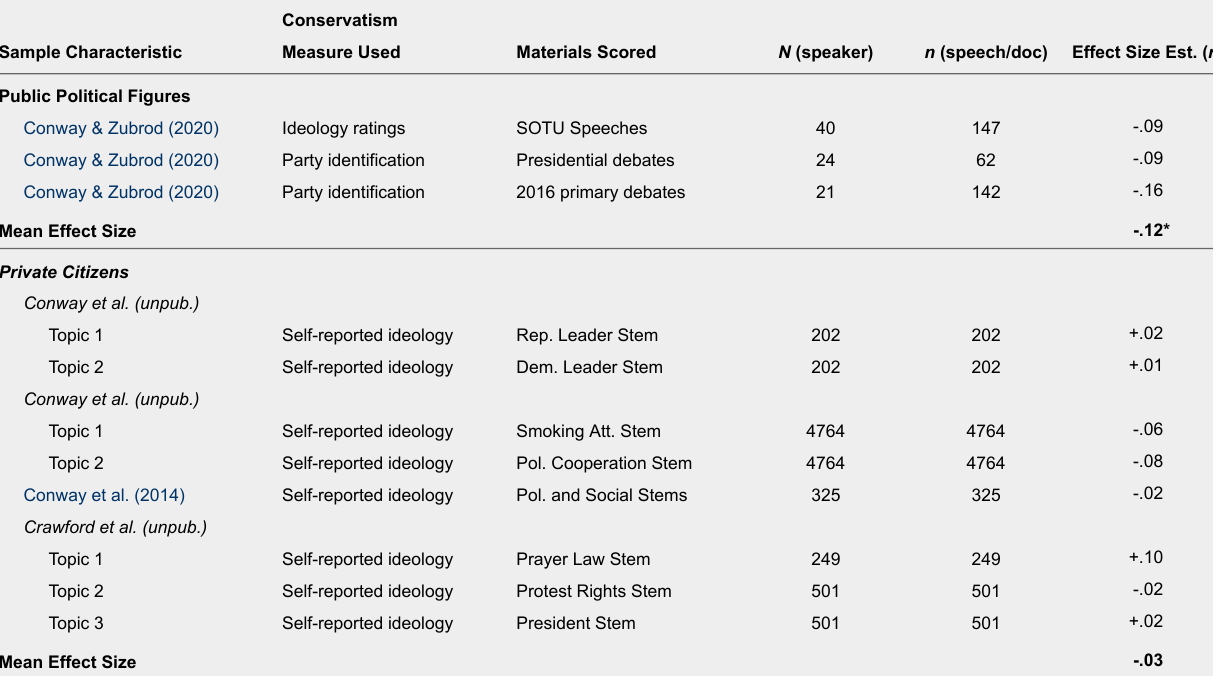
Validity Test 5: Correlations Between Conservatism and Integrative Complexity in Public Political Figures and Private Lay Citizen Samples